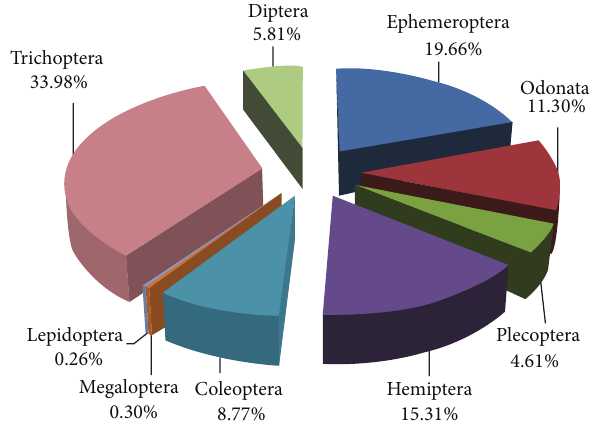
Figure 2: Composition of aquatic insect orders of the three streams in the Mae Klong Watershed during a period of seven